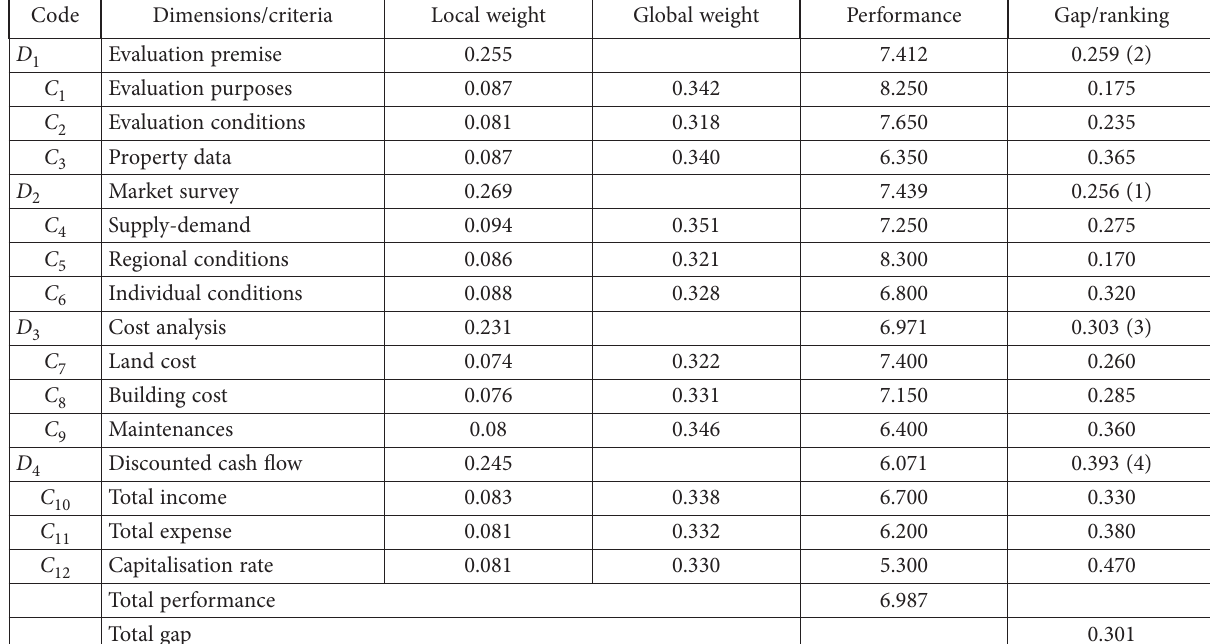
Table 5. Gap value of hotel appraisal criteria by modified VIKOR